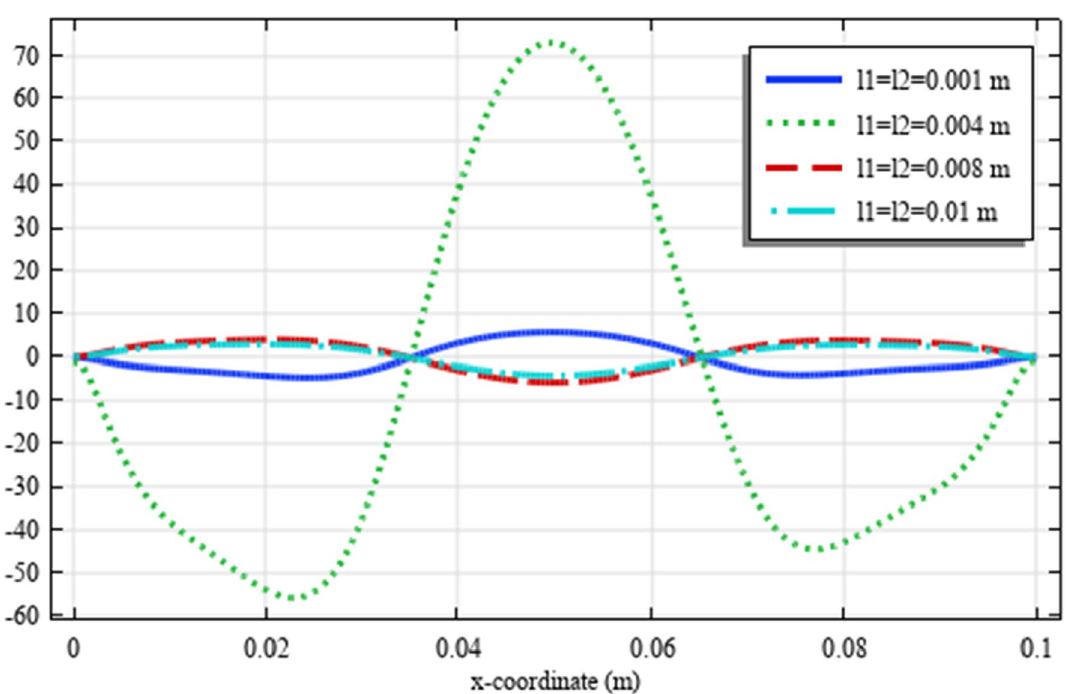
Figure 10. The micro-strain s xx ( x , b / 2 )/ s 0 for different values of ℓ 1 and ℓ 2 (COMSOL